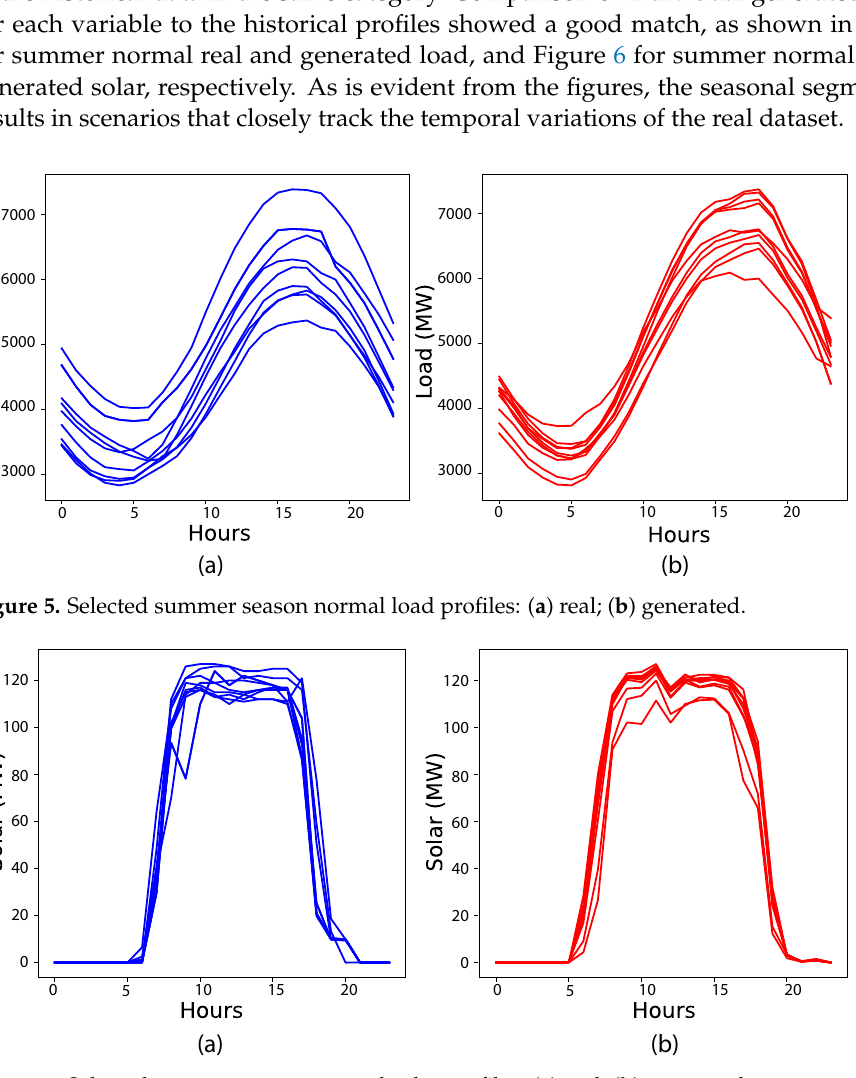
Figure 6. Selected summer season normal solar profiles: ( a ) real; ( b )